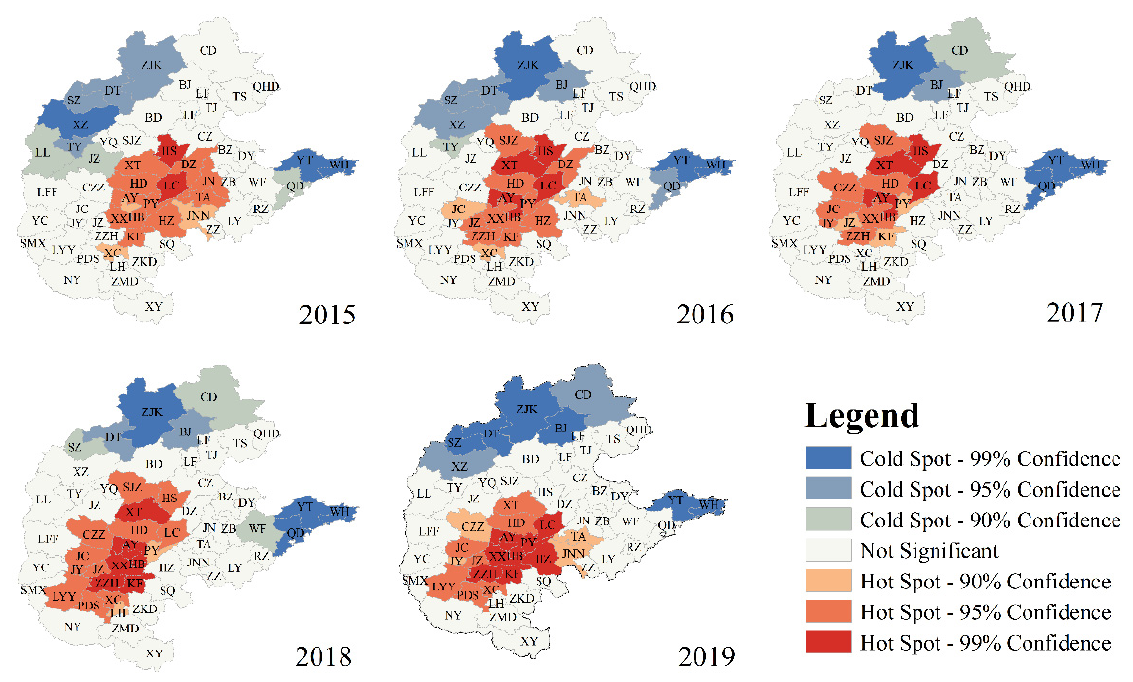
Figure 5. Cold–hot spot diagram of PM 2.5 concentration from 2015 to 2019.